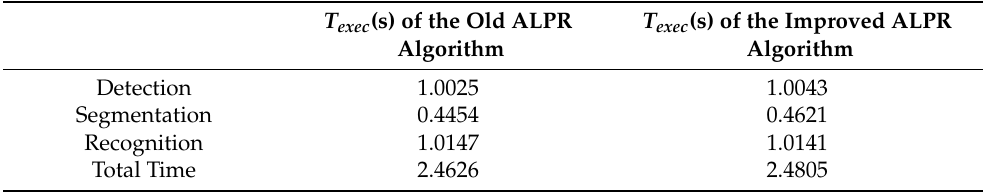
Table 6. Comparison between the execution time of the old and improved ALPR algorithms. T exec (s) of the Old ALPR T exec (s) of the Improved ALPR Algorithm